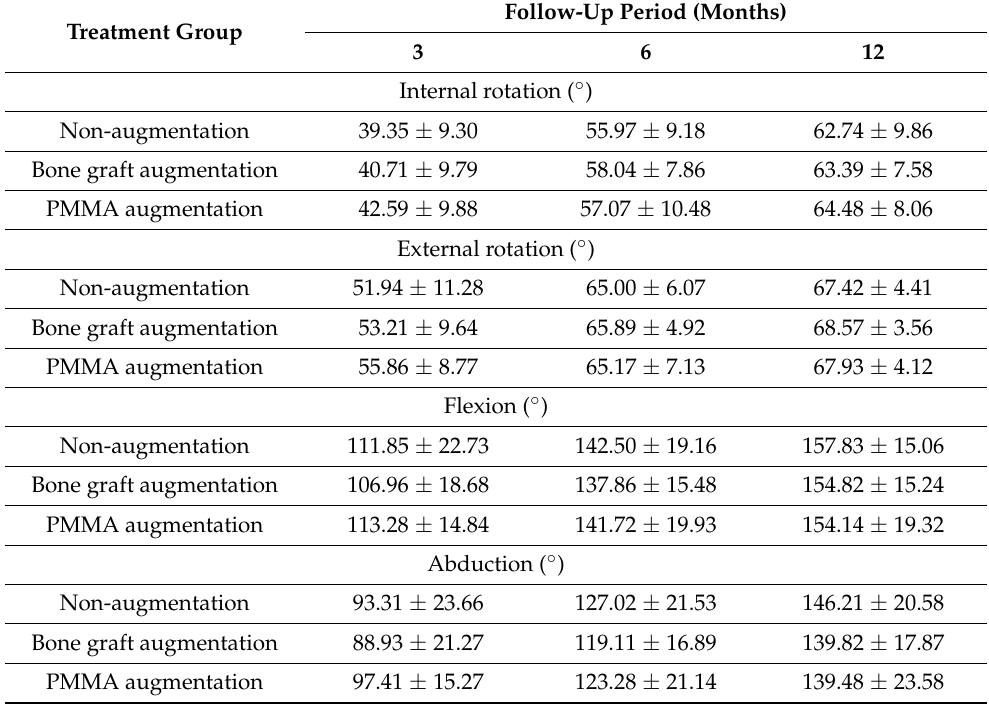
Table 5. Patients ROM scores in the treatment groups at three different follow-up periods, presented in terms of mean value and standard deviation.